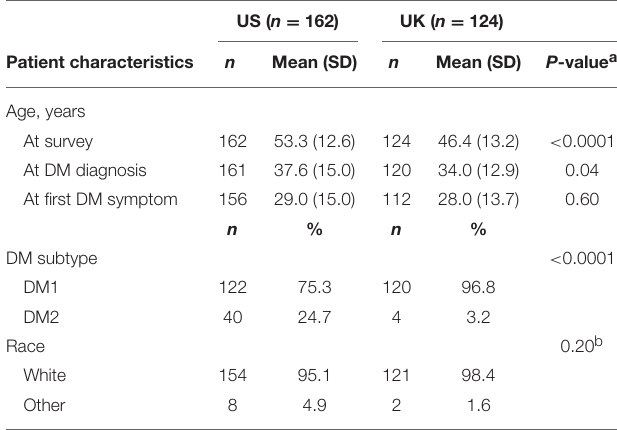
TABLE 1 | Characteristics of female DM patients in the US and UK